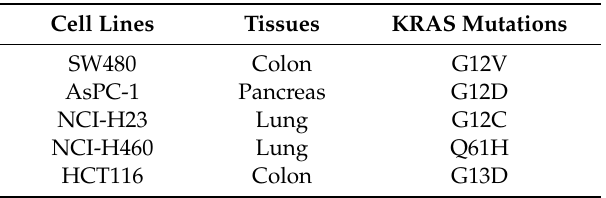
Table 4. Characteristics of KRAS mutant cell